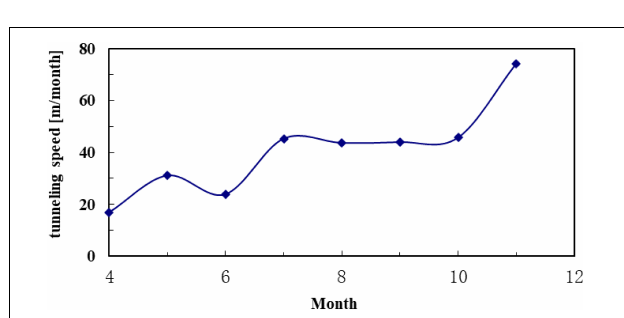
FIGURE 13 | Variation in roadway gas concentration for the process of flushing.